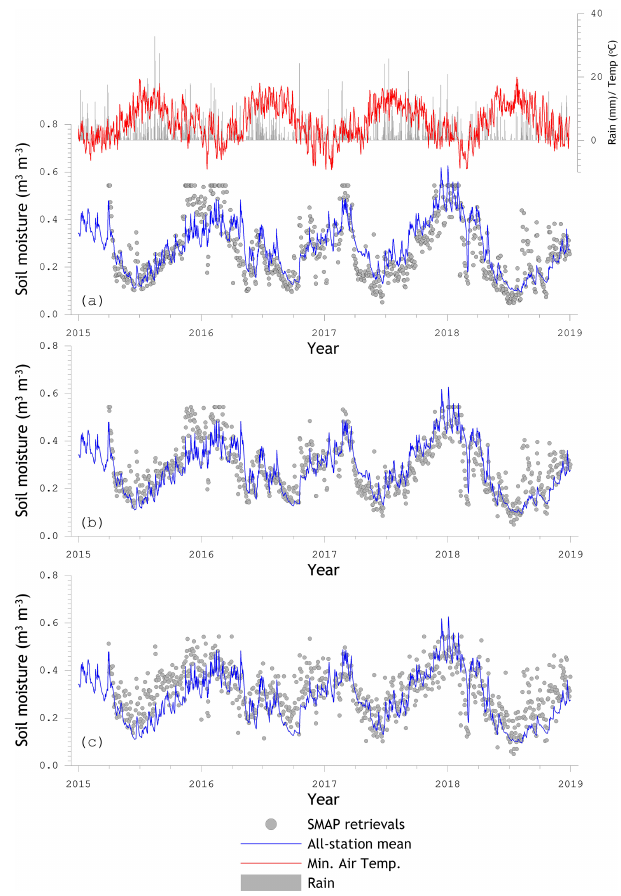
Figure 8. Time series of daily minimum air temperature, daily rain- fall sums, all-station mean soil moisture, and SMAP retrievals for reference pixel 3606 and the (a) Single Channel Algorithm at H polarization (SCA-H), the (b) Single Channel Algorithm at V po- larization (SCA-V), and the (c) Dual Channel Algorithm